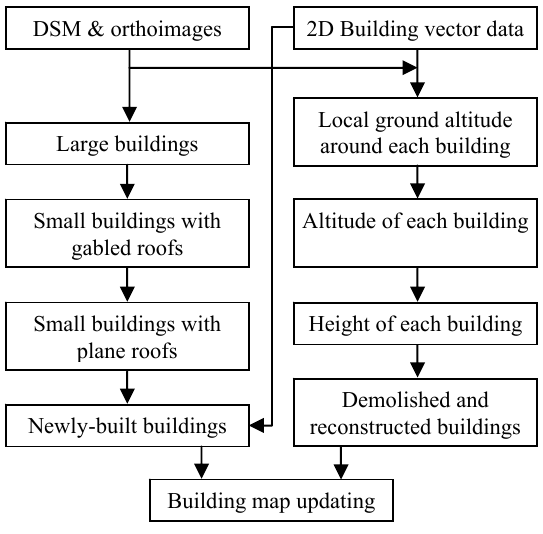
Figure 1. Flow chart of building map